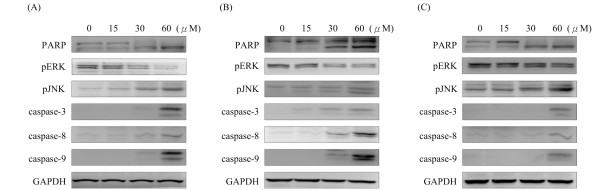
Effects of squamocin on apoptosis. Cells were treated with 15, 30, and 60 μM squamocin for 24 h. Proteins were extracted and analyzed by Western blotting. GAPDH was used as a loading control. Squamocin enhanced caspase-3, -8, and -9 activities, cleaved the functional protein of PARP, increased phosphorylation levels of ERK, and decreased phosphorylation levels of JNK. (A) GBM841 cells. (B) Huh-7 cells. (C) SW620 cells. Data are representative of three independent experiments.